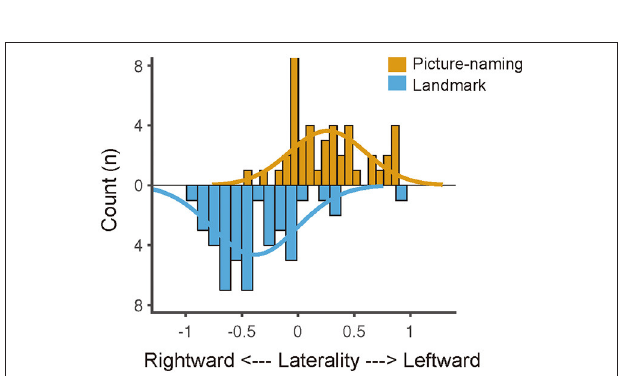
FIGURE 5 | Laterality index distribution of the picture-naming and landmark task. The laterality index distribution was fitted by Gaussian curves, suggesting a left-lateralized distribution of the picture-naming task and a right-lateralized distribution of the landmark task. The difference between the two distributions was significant ( p < 0.001, Kolmogorov–Smirnov